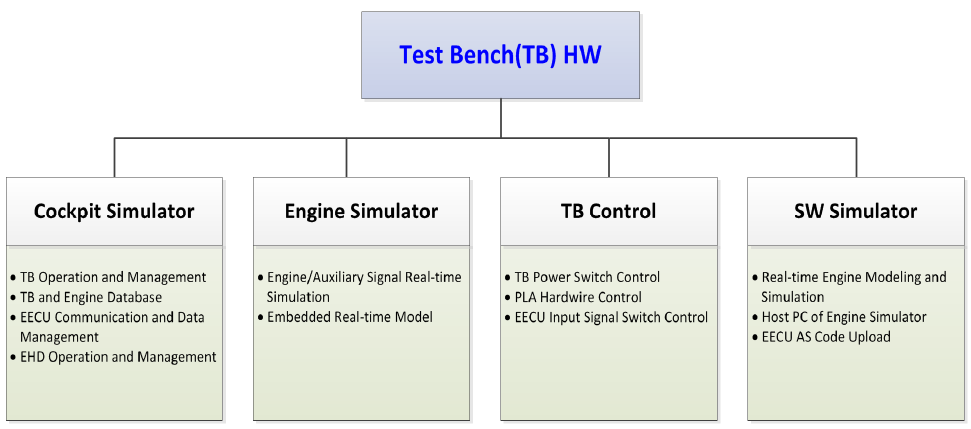
Figure 4. Structure of test bench hardware.